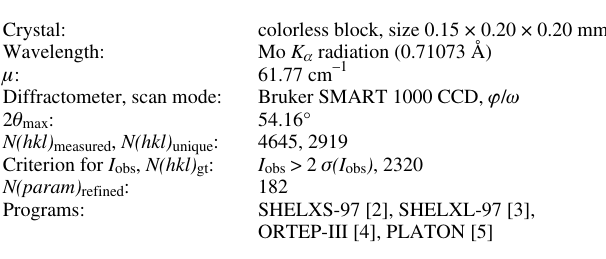
Table 1. Data collection and